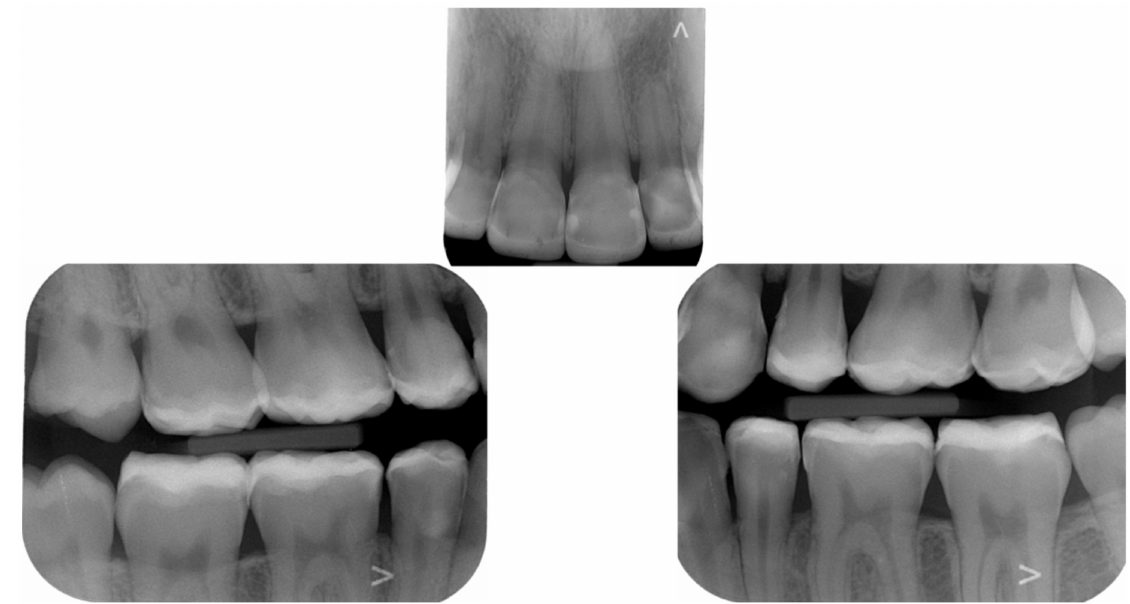
Figure 37. Final radiological documentation.